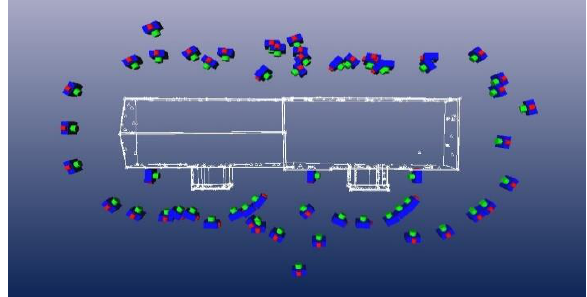
Figure 1. Camera points and control points for